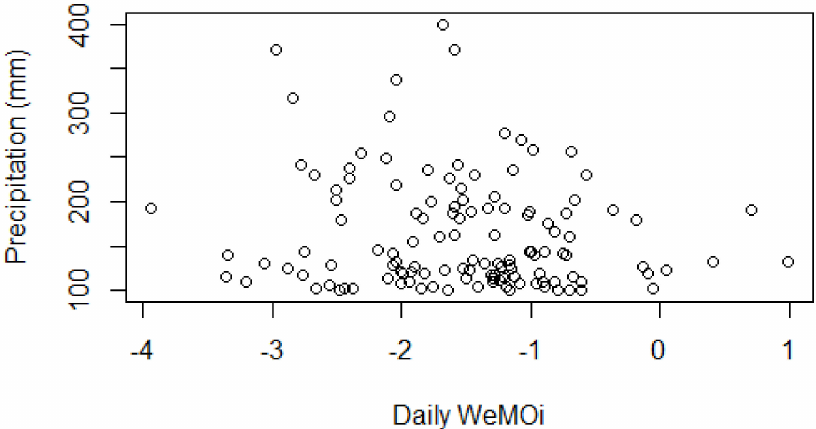
Figure 7. Statistical distribution of the daily values of the WeMOi for days with intense rainfall in the 1981–2020 period in the province of